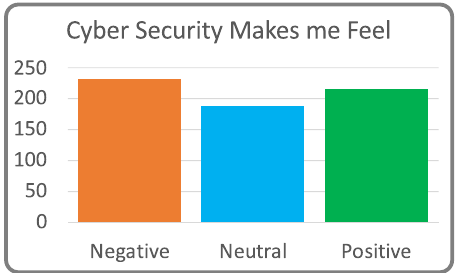
Fig. 4 Study 1 ’ s tallied ranking collected by the EARNEST measurement instrument (Negative, Neutral,